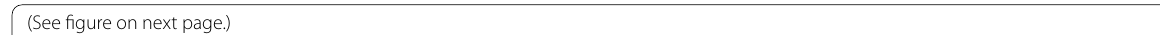
(See figure on next page.) Fig. 4 Pathological findings. a Macroscopic findings revealed two squamous cell carcinomas. One was located in the upper thoracic esophagus, and the other was located in the middle thoracic esophagus. b , c Hematoxylin and eosin staining of the tumor located in the b unirradiated upper thoracic esophagus and c previously irradiated middle thoracic esophagus. The dashed black lines point to the area of each tumor. Black and yellow arrows show the thickness of the muscularis propria and adventitia, respectively. d , e Microscopic findings of the adventitia of the d unirradiated normal esophagus and e previously irradiated lesion (original magnification 200). The adventitia of the irradiated esophagus had severe fibrosis × and thickness compared to the normal esophagus located outside the irradiation